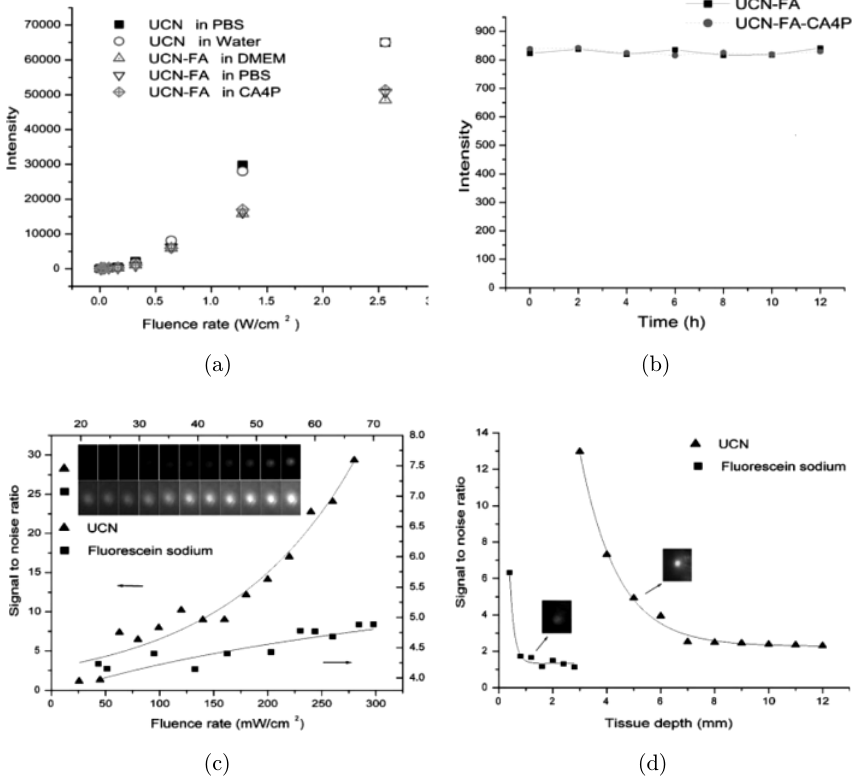
Fig. 5. (a) The intensity of UCNP – FA dissolved in di®erent aqueous solutions. (b) The anti-photobleaching capability of UCNP – FA. UCNP – FA was irradiated for 12 h continually with a laser (980 nm, 800 mW cm (cid:1) 2 ). (c) SNR of UCN and °uorescein sodium during laser excitation with di®erent °uence rates. (d) SNR of the UCNPs and °uorescein sodium during laser excitation at di®erent tissue depths. (Reproduced from \High-sensitivity in vivo imaging for tumors using a spectral up-conversion nanoparticle NaYF 4 : Yb 3 þ , Er 3 þ in cooperation with a microtubulin inhibitor" with permission from The Royal Society of